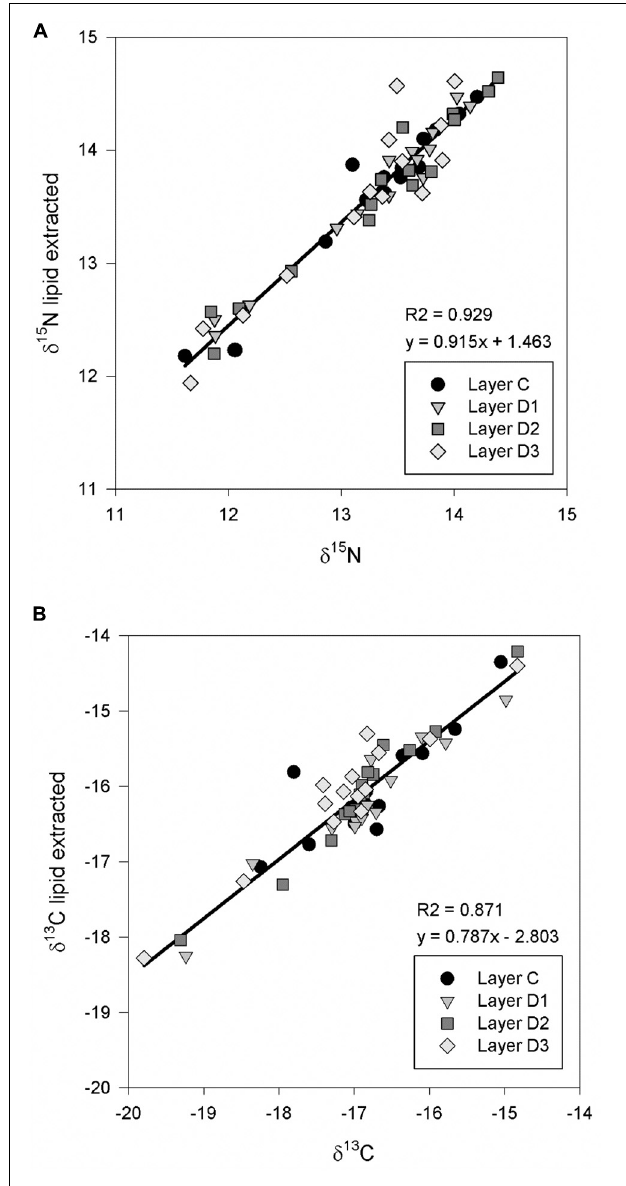
FIGURE 3 | Comparison of nitrogen-15 (A) and carbon-13 (B) stable isotopes ratios ( δ 13 C and δ 15 N) from different epidermal strata from eastern gray whales ( N = 15); corneum (Layer C), spinosum (Layers D1 and D2) and basale (Layer D3) with and without lipid extraction.